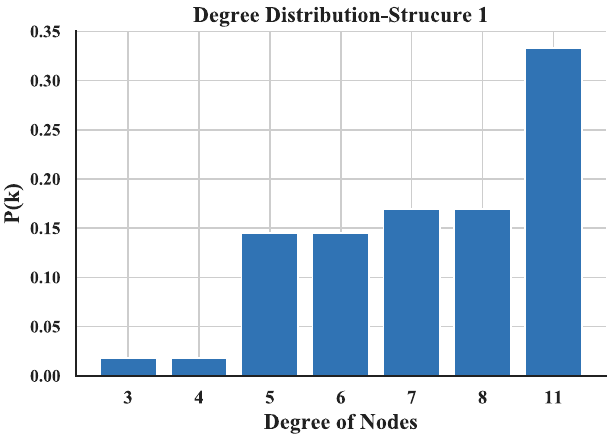
Figure 14. Distribution of degree of Structure 1.